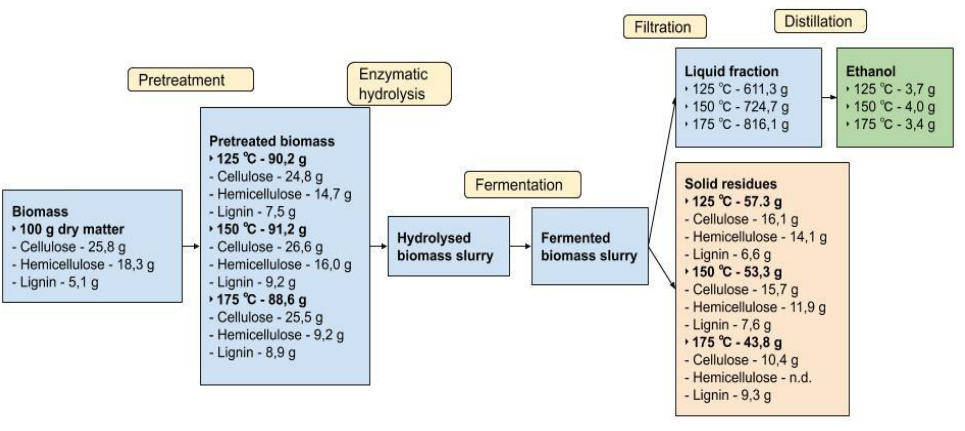
Fig. 5. Mass balance of bioethanol production process when different pretreatment temperatures were used and solid and liquid parts of hydrolysis slurry was fermented